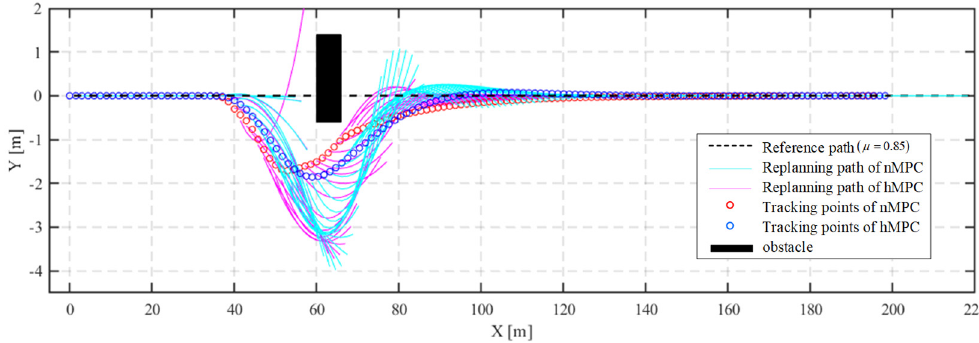
Figure 8. Path replanning and collision avoidance on the road of µ = 0.85.